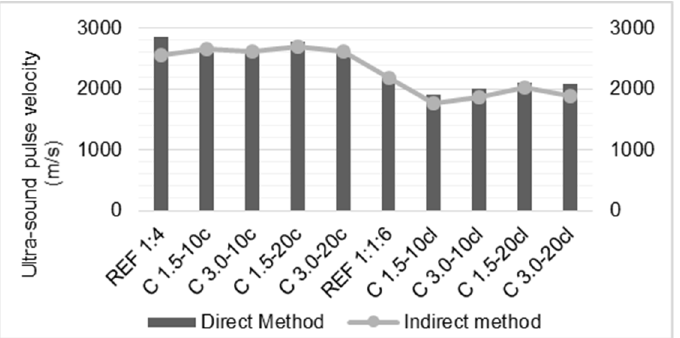
Figure 7. Ultra-sound pulse velocity of the mortars.